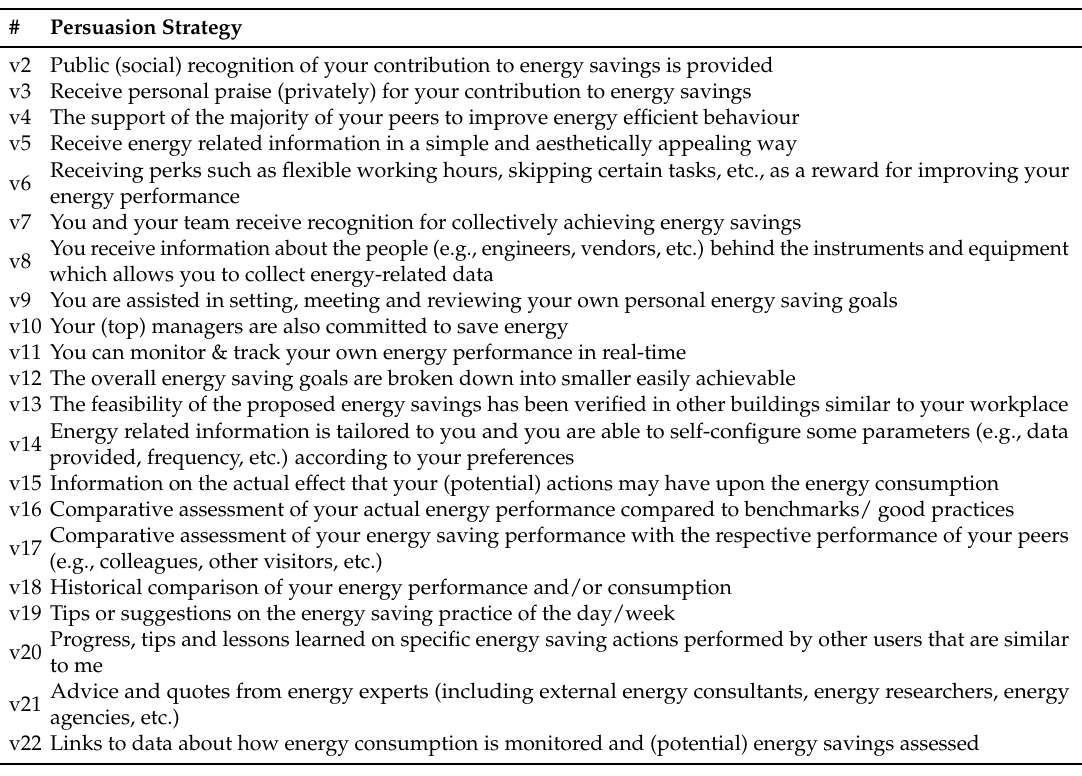
Table 2. Description of the 21 Persuasion Strategies Identified.